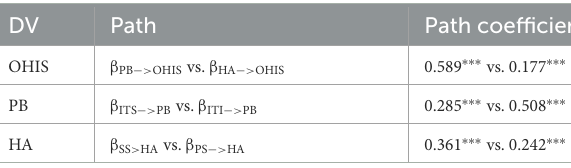
TABLE 5 Path coefficients